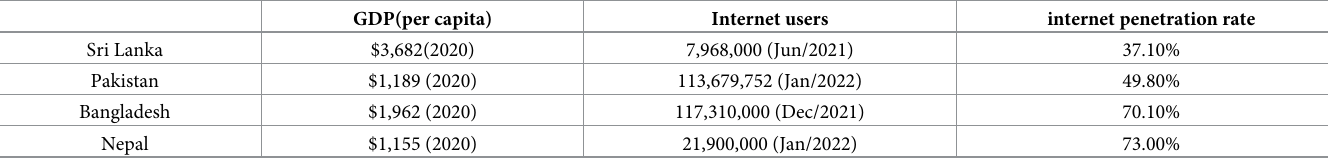
Table 14. Market scale and internet infrastructure in four countries. GDP(per capita) Internet